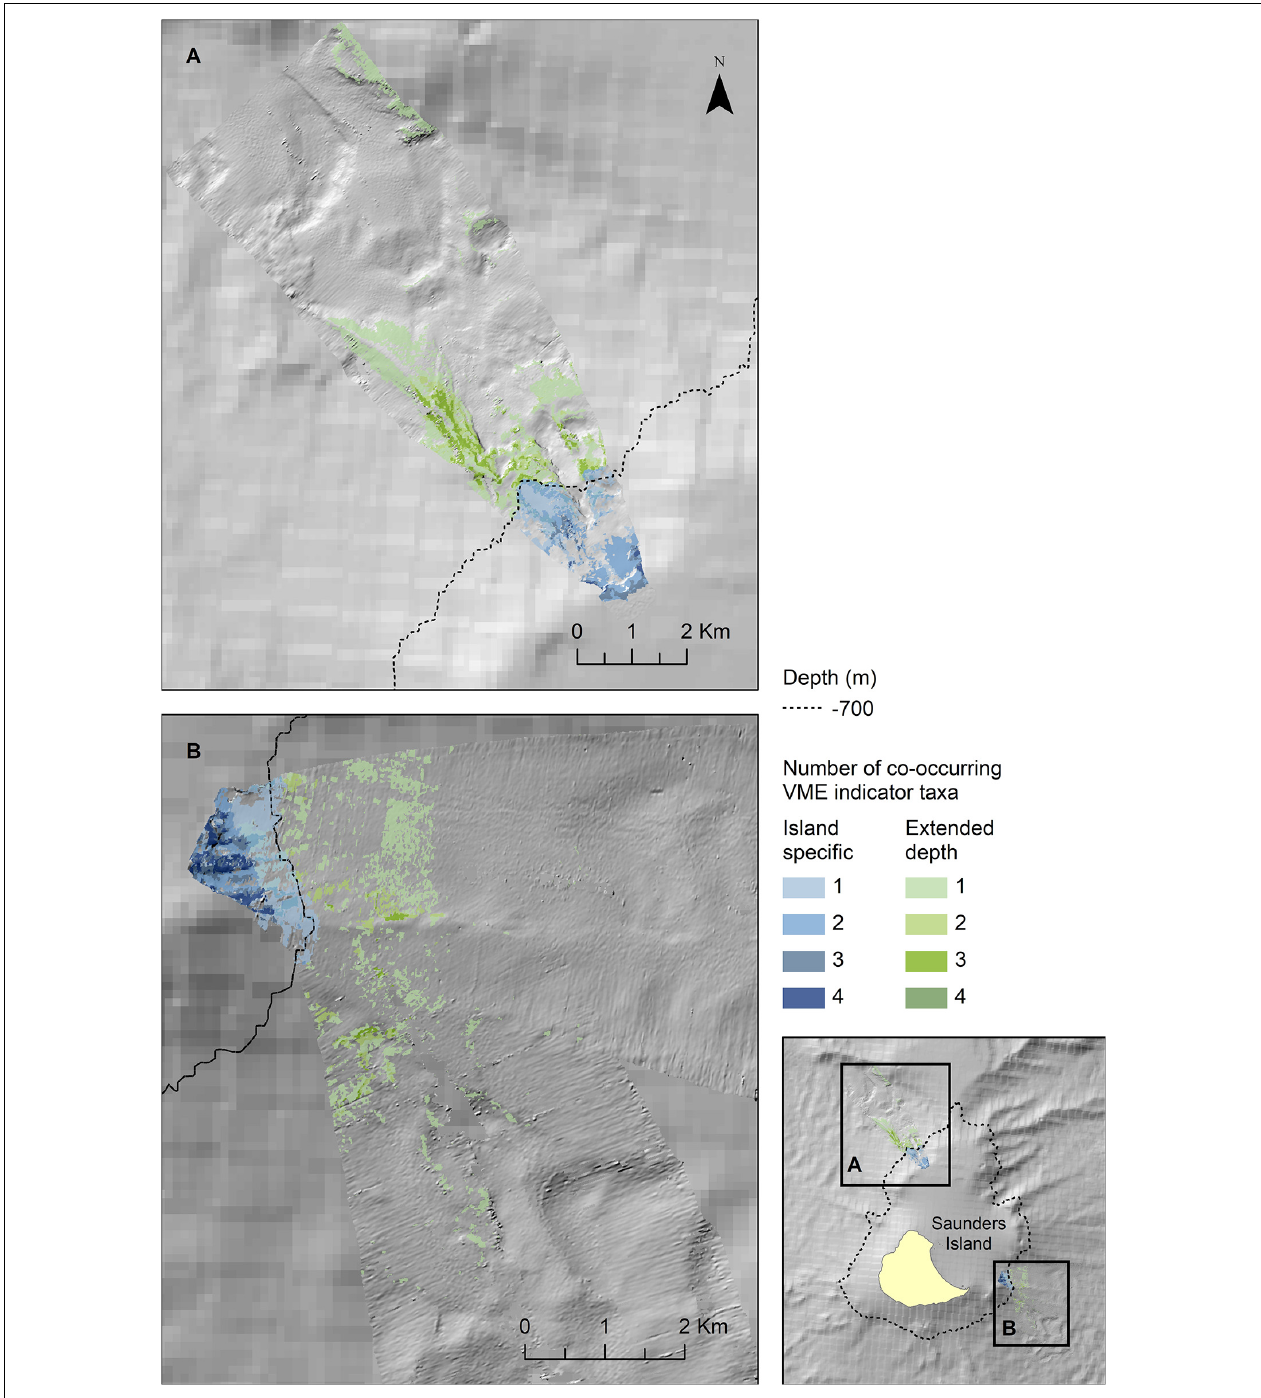
FIGURE 8 | Extrapolated extent of potential ly suitable habitat for VME indicator taxa in the two survey locations to the northwest (A) and southeast (B) of Saunders Island. Shown values refer to the number of VME indicator taxa (bottlebrush corals, branching corals, whip corals and sponges) for which suitable habitat is likely to co-occur. Blue colours indicate the extent within observed depth limit for this location, green colours indicate topographically suitable habitat present beyond the observed depth. High resolution bathymetry from DY99 is shown overlain on the South Sandwich Islands bathymetry compilation by Leat et al. (2014).